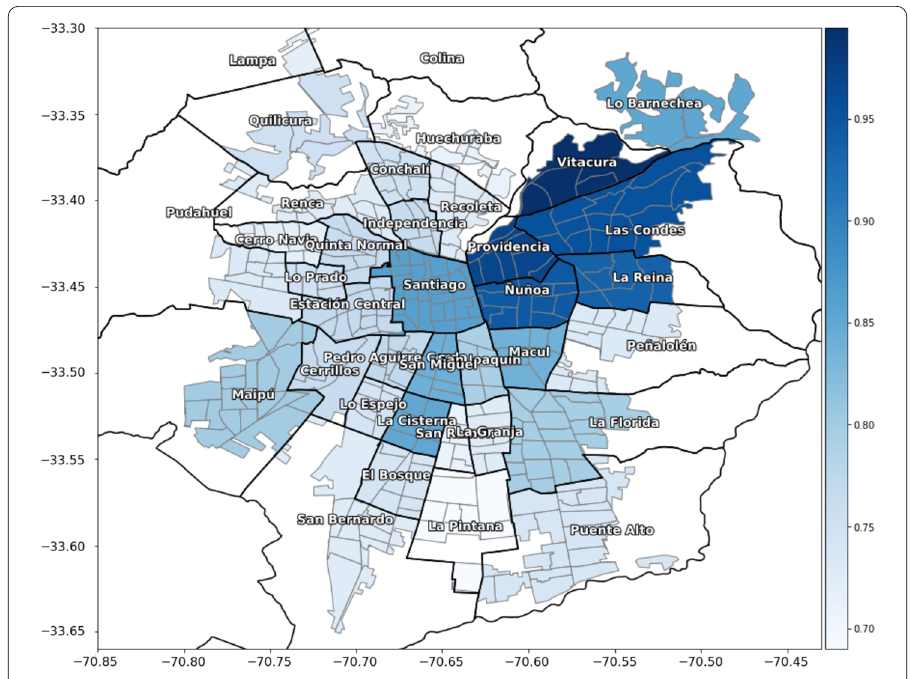
Figure 1 HDI distribution for the urban area of the RegionMetropolitanadeSantiago